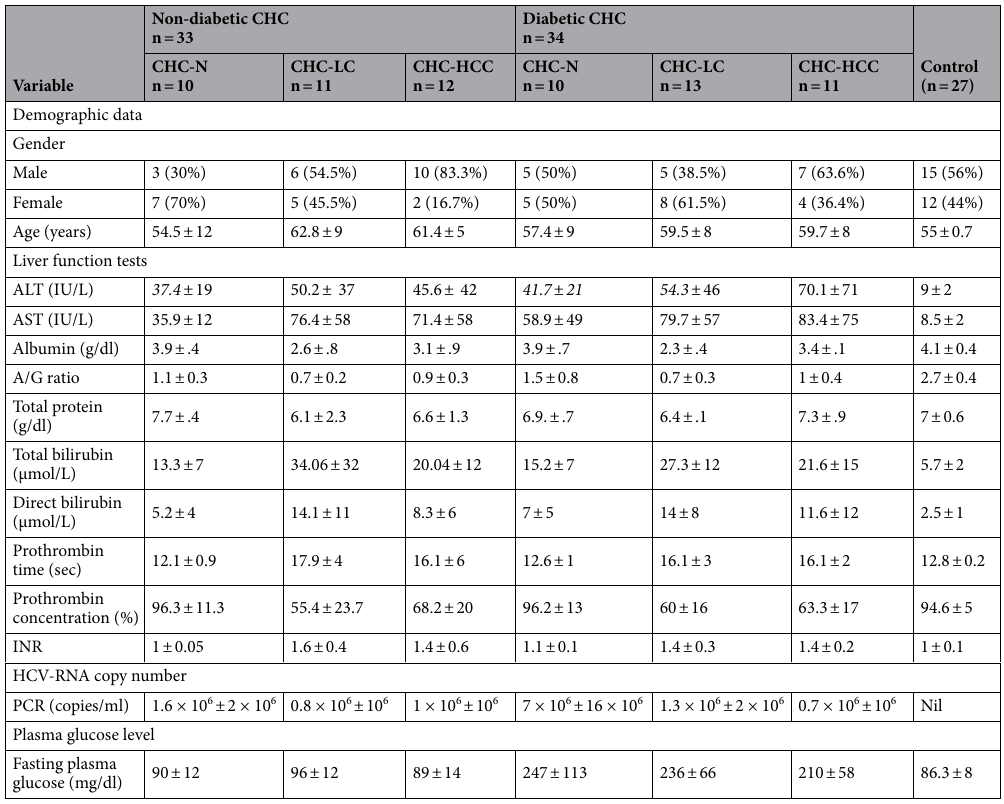
Table 1. Characteristics of the different patients’ groups CHC-N chronic hepatitis C with no cirrhosis or carcinoma, CHC-LC liver cirrhosis, CHC-HCC hepatocellular carcinoma, AST Aspartate transaminase, ALT Alanine transaminase , INR International Normalized Ratio , A/G Albumin /Globulin ratio. Results displayed as mean ± standard deviation (SD), *Result displayed as a number (percent from the corresponding group).